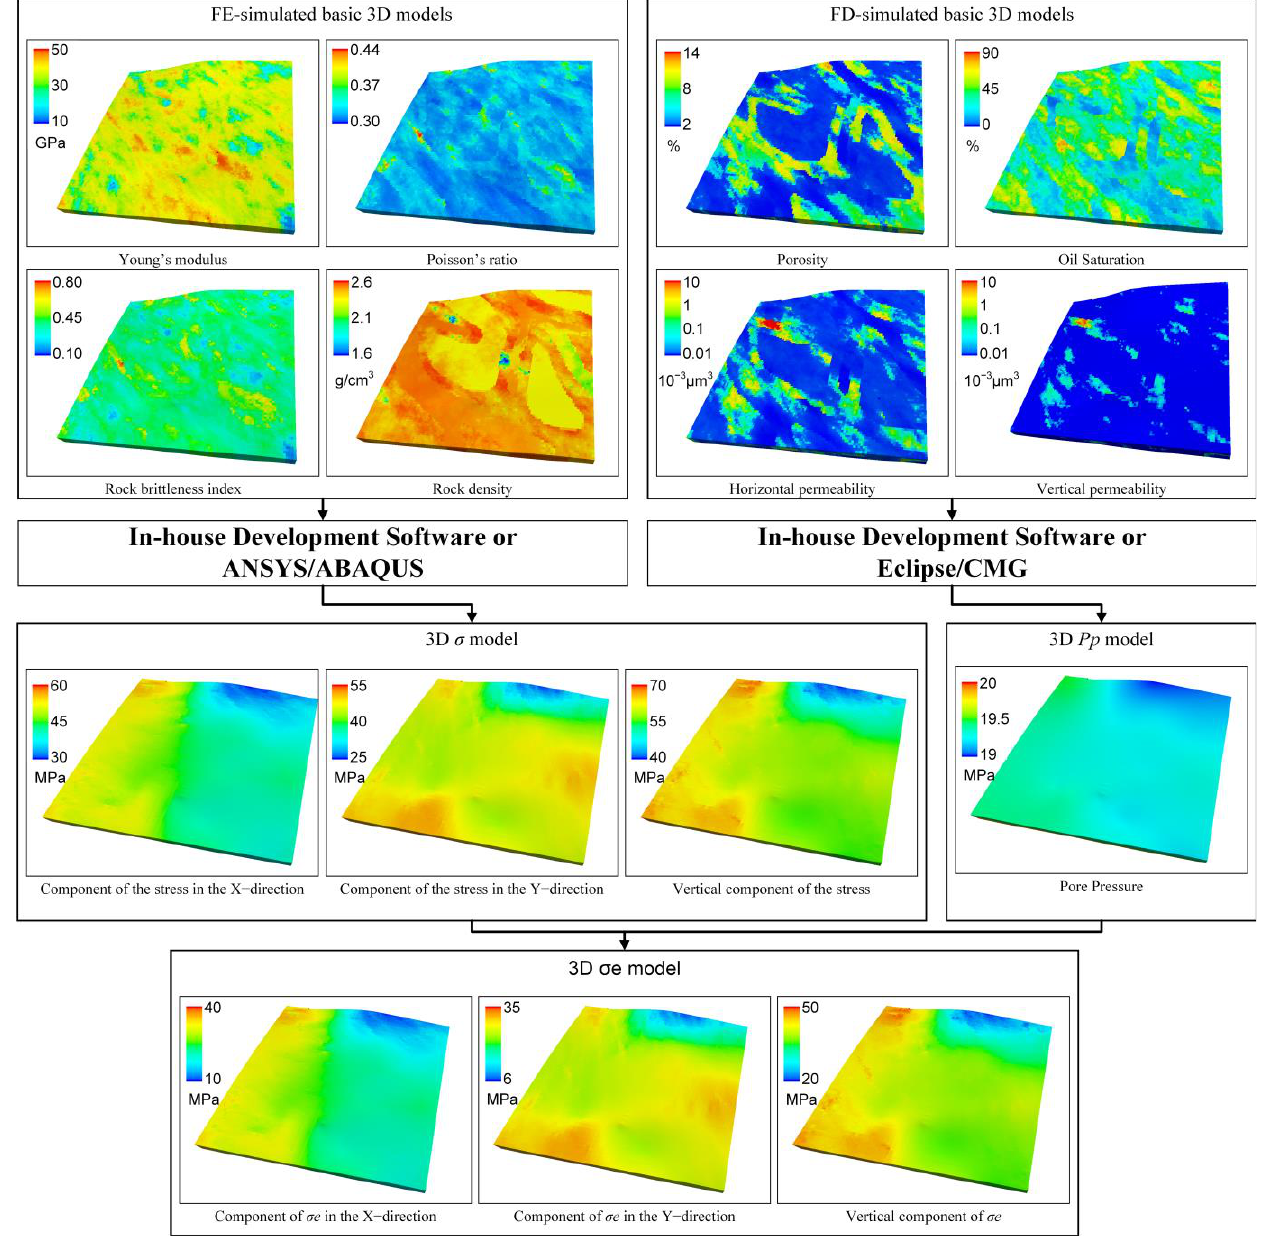
Figure 6. Initial σ e field in well area X established through reservoir – geomechanics coupling.